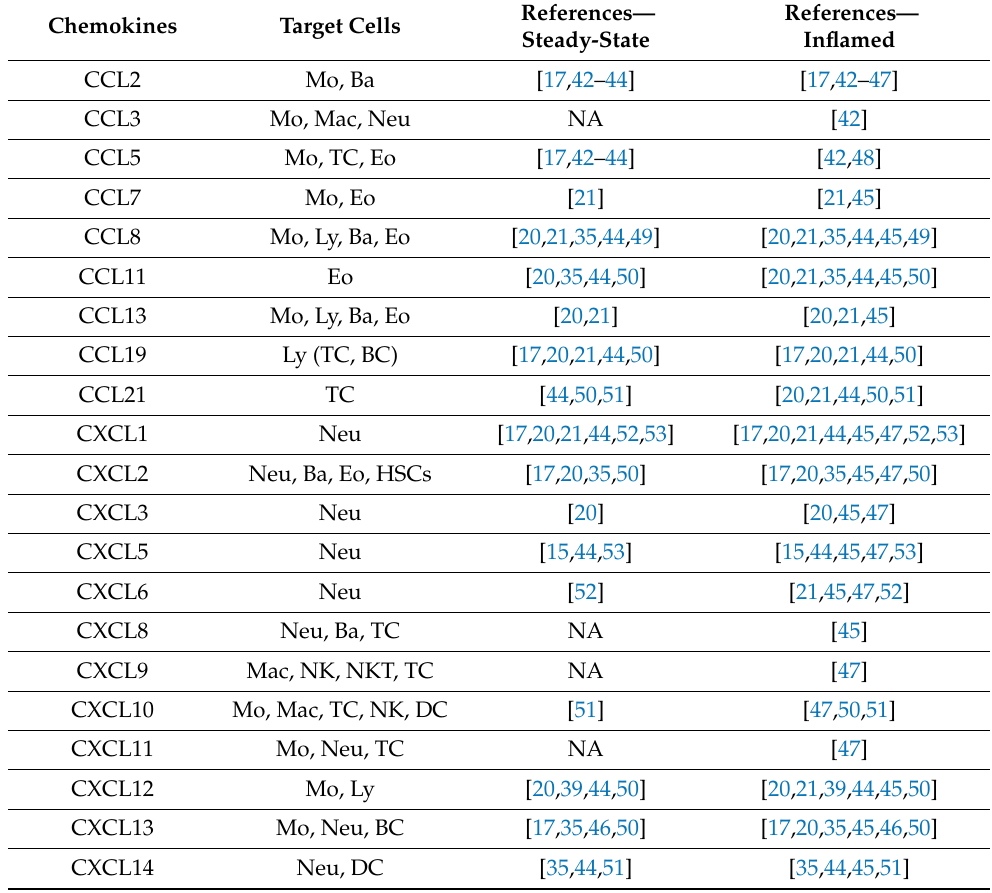
Table 2. List of chemokines expressed by IMCs under steady-state and inflammatory condi- tions. Target cell information is based on the Uniprot database. Ba—basophils; BC—B cells; DC—dendritic cells; Eo—eosinophils; HSC—hematopoietic stem